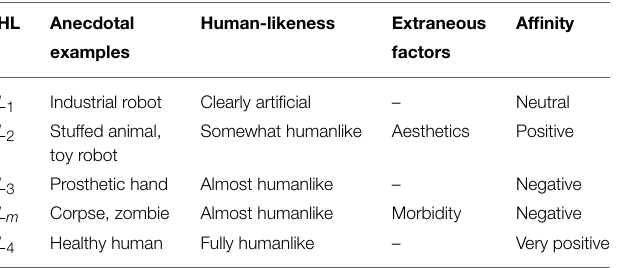
TABLE 1 | Focal points on the human-likeness dimension of the uncanny valley graph.